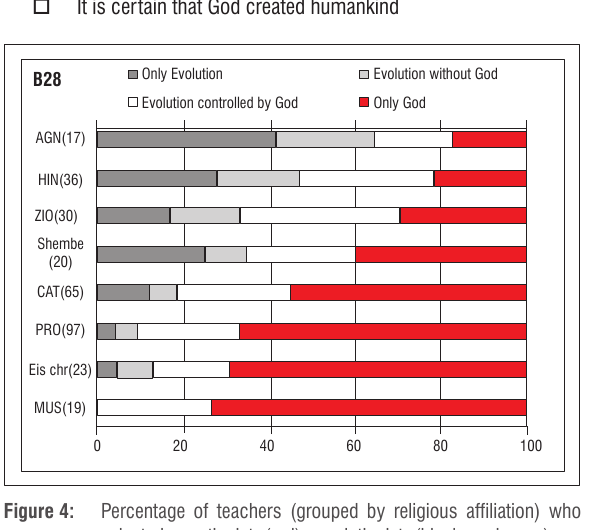
Figure 4: Percentage of teachers (grouped by religious affiliation) who selected creationist (red), evolutionist (black and grey), or mixed creationist and evolutionist (white) answers to question B28 on the origin of humankind.